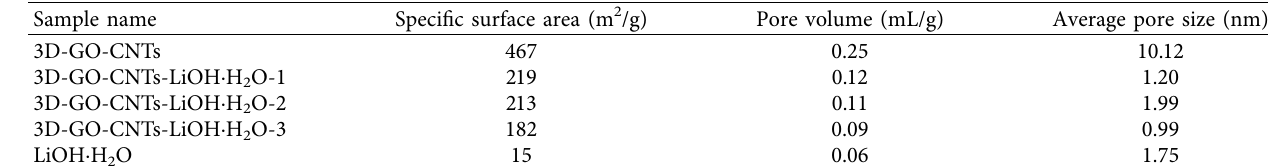
· H · H 2 O-1; (c) 3D-GO-CNTs-LiOH 2 O-2; (d) 3D-GO-CNTs- · H 2 O and LiOH 2